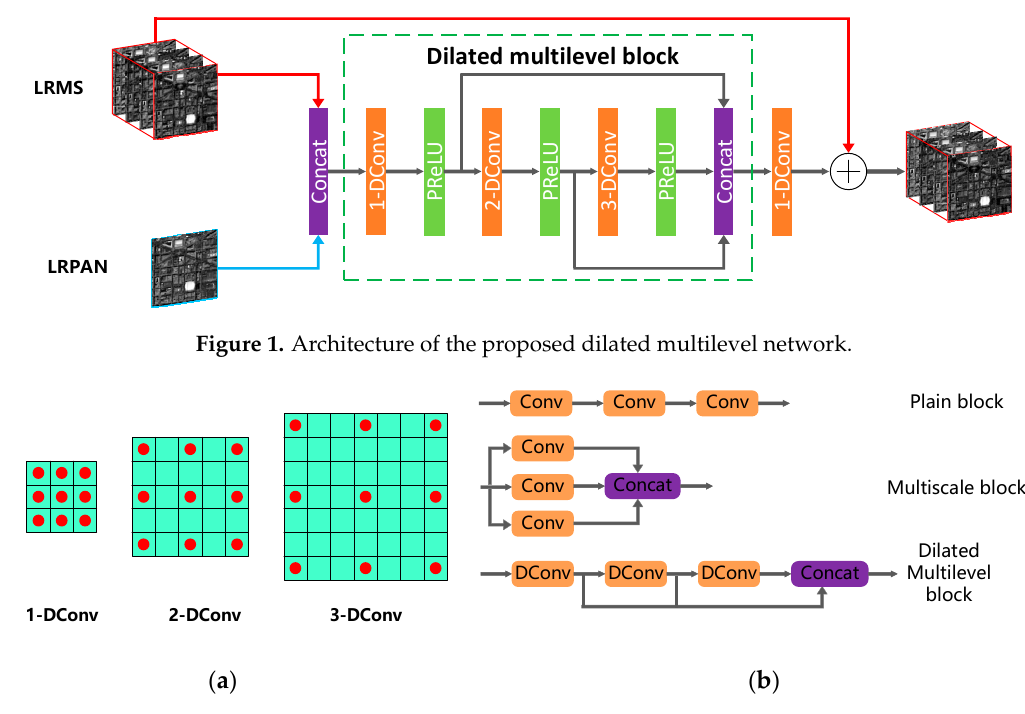
Figure 1. Architecture of the proposed dilated multilevel network.